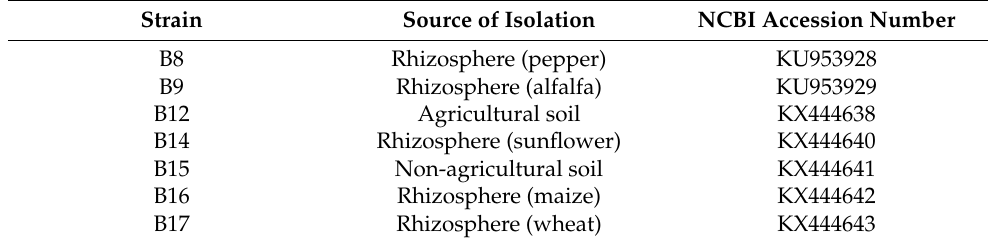
Table 1. Bacillus megaterium strains isolated from soil at different locations in Serbia.